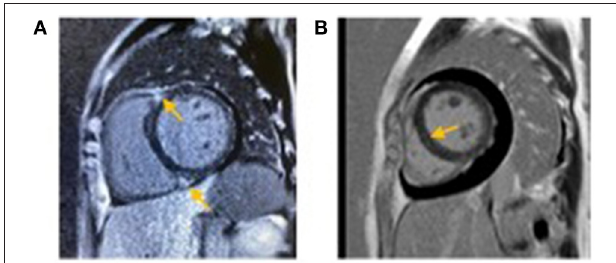
FIGURE 1 | (A) Case 2 (Yellow arrow): Cardiac magnetic resonance imaging showing patchy delayed enhancement of the insertion at both ends of the ventricular septum. (B) Case 4 (Yellow arrow): Cardiac magnetic resonance imaging showing linear delayed enhancement in the basal segment of the ventricular